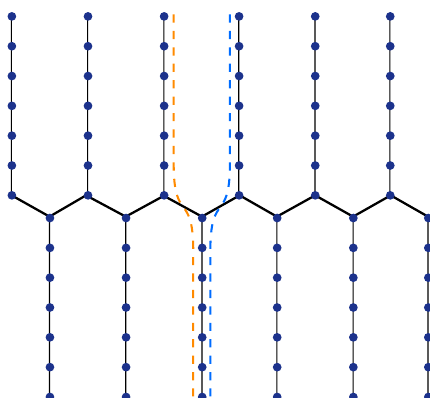
= 0.1 (green) and 0.82 bb